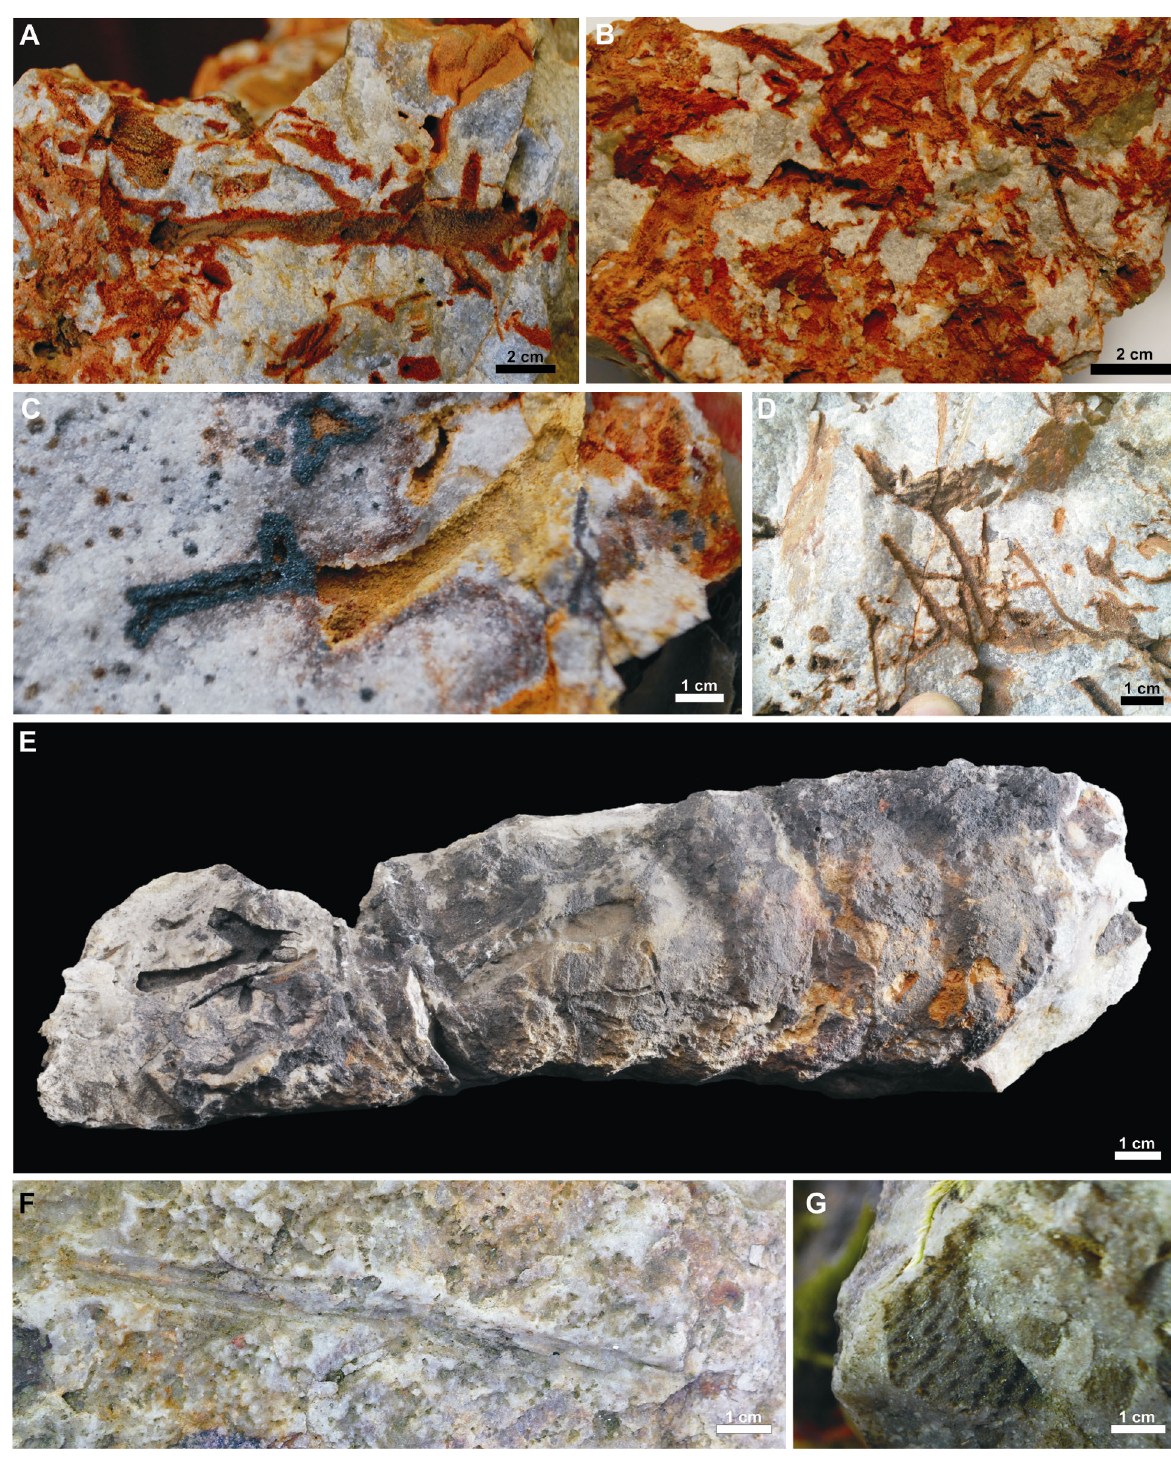
Fig. 2. Fossil remains collected in the locality. A , part of a thick root specimen (collection No. Muz. PGI 1755.II.220); B , C , close up of some small individuals of roots (collection No. Muz. PGI 1755.II.221); D , an example of roots crossing each other (collection No. Muz. PGI 1755.II.222); E , nautiloid shell covered by roots (collection No. Muz. PGI 1755.II.223); F , acanthodian fin spine (specimen in the field); G , fragment of placoderm plate (specimen in the